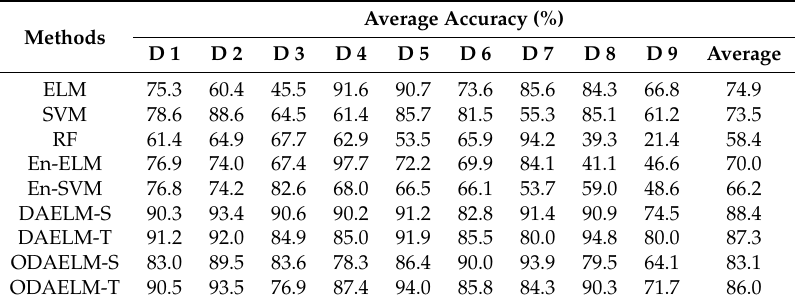
Table 5. Comparisons of average classification accuracies using setting